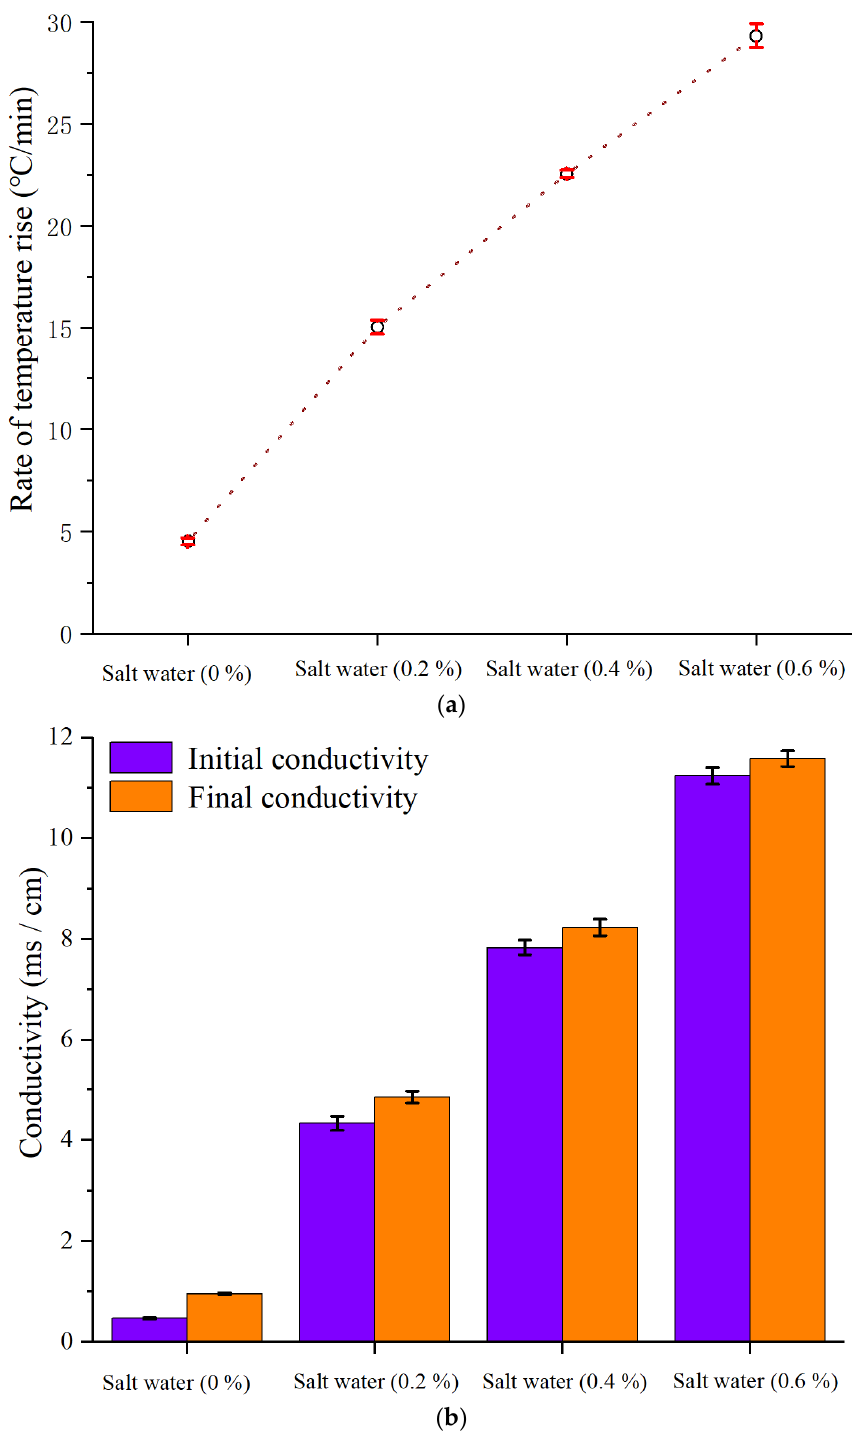
Figure 5. ( a ) Effect of NaCl solutions on the temperature rise; ( b ) effect of NaCl solutions on the